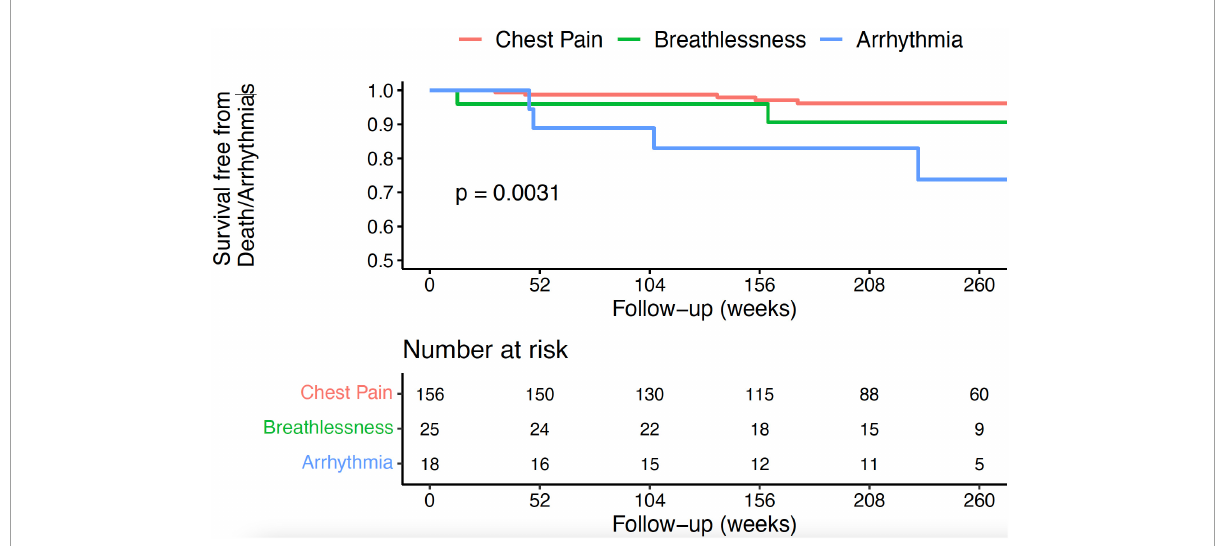
FIGURE1 Kaplan–Meier curve for all-cause mortality, resuscitated cardiac arrest, and appropriate implantable cardioverter defibrillator (ICD) therapy following hospital discharge in patients with AM, according to clinical presentation.